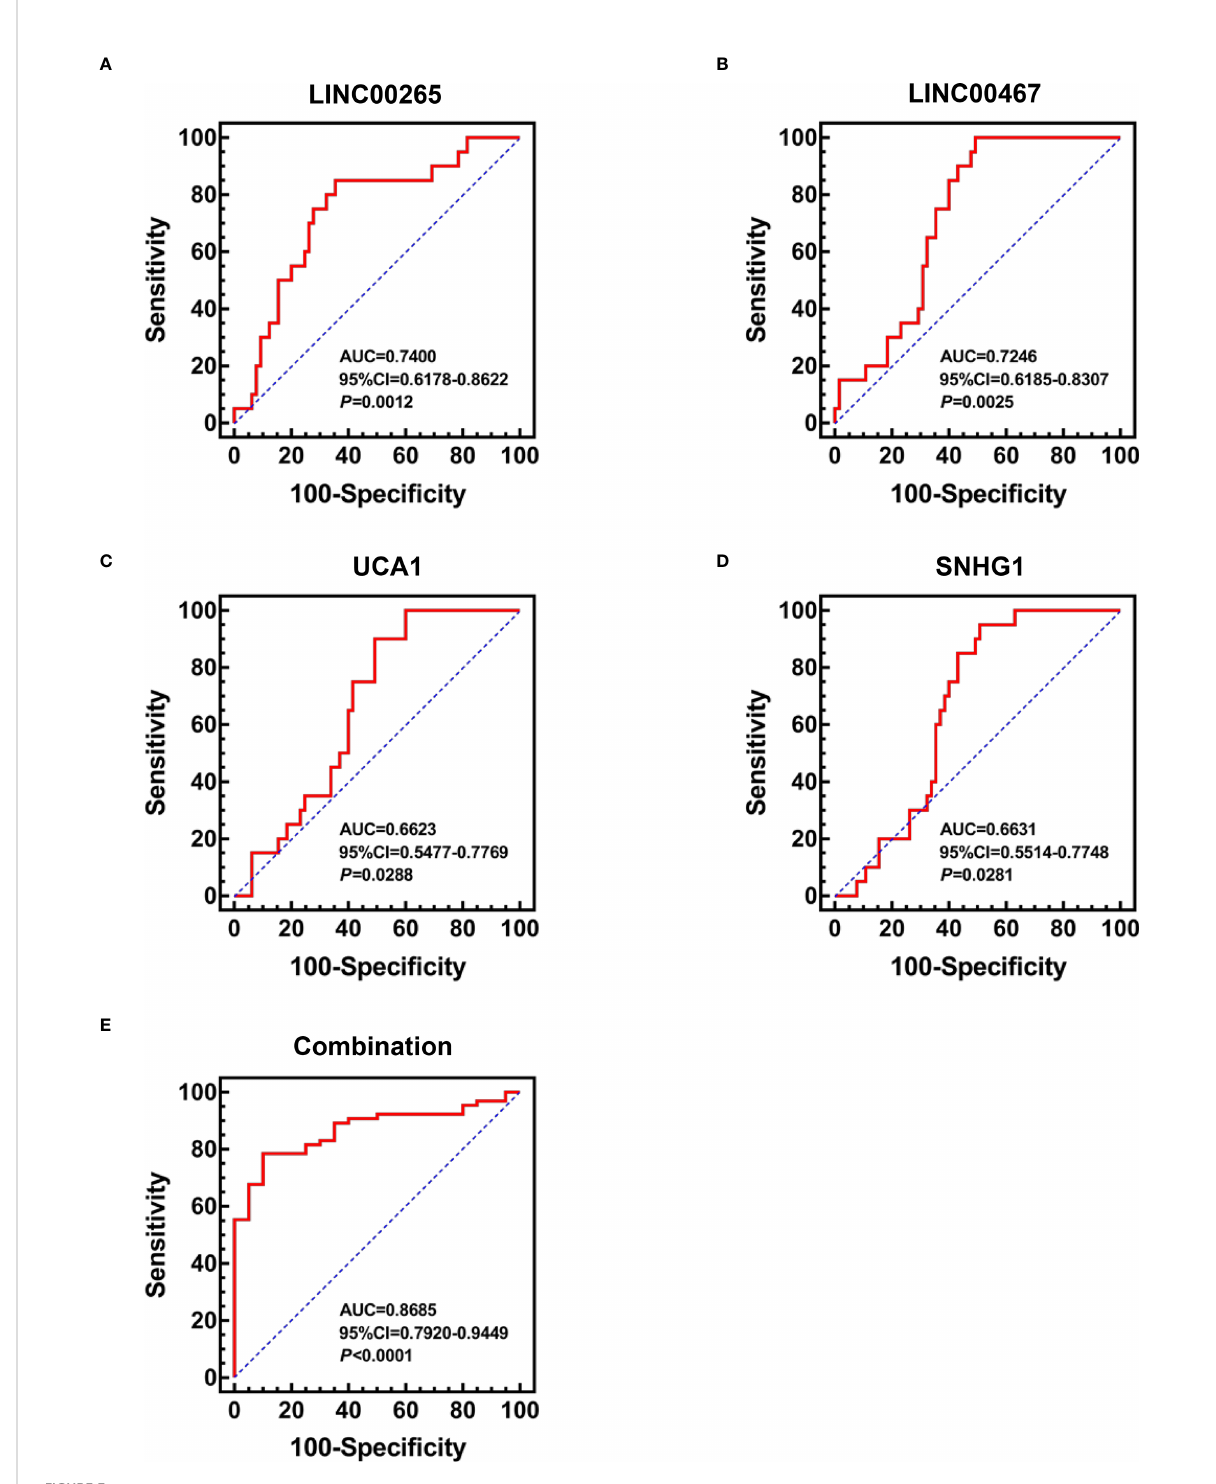
FIGURE 3 Diagnostic Ef fi ciency of the Plasma Exosomal LncRNAs for AML. (A-D) ROC analysis of the individual diagnostic ef fi ciency of four plasma exosomal lncRNAs (LINC00265, LINC00467, UCA1, and SNHG1) in distinguishing AML patients (n = 65) from HD (n = 20). (E) ROC analysis and Binary logistic regression analysis of the combined diagnostic ef fi ciency of four plasma exosomal lncRNAs (LINC00265, LINC00467, UCA1, and SNHG1) in distinguishing AML patients (n = 65) from HD (n = 20). AUC: area under the curve; CI: con fi dence